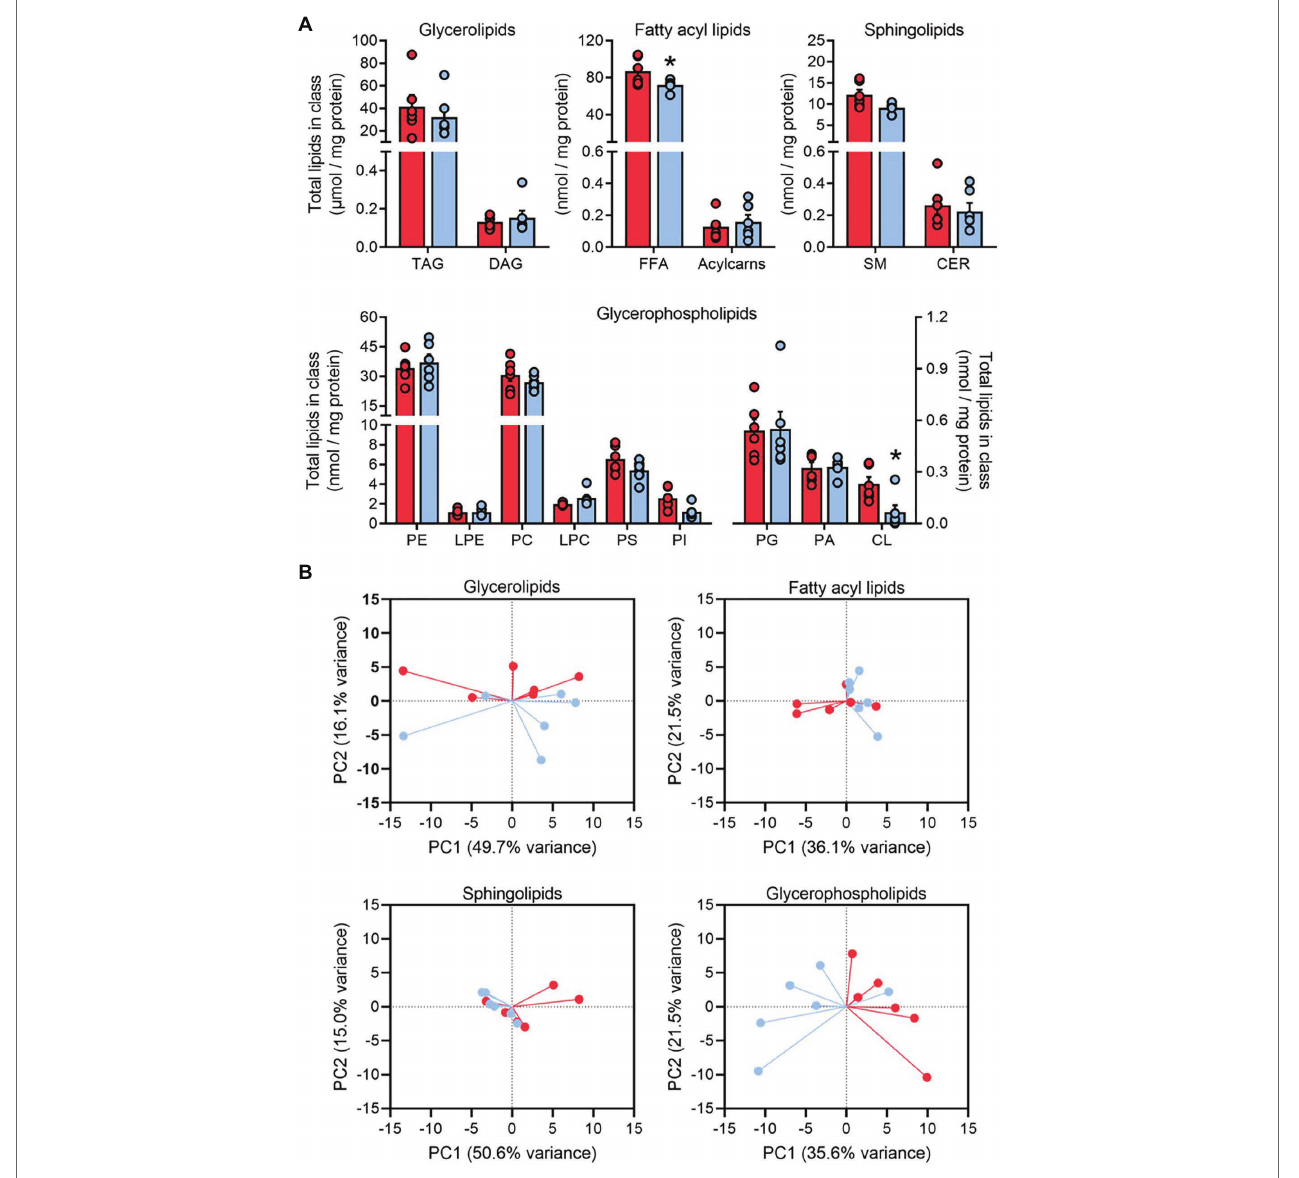
FIGURE 2 | The glycerophospholipid profile responds to pioglitazone treatment in adipose tissue. Lipid class totals in adipose tissue (A) for triglyceride, diacylglyceride, free fatty acids, acylcarnitine (acylcarns), sphingomyelin (SM), ceramide, phosphatidylethanolamine (PE), lyso-phosphatidylethanolamine, phosphatidylcholine (PC), lyso-phosphatidylcholine, phosphatidylserine (PS), phosphatidylinositol (PI), phosphatidylglycerol (PG), phosphatidic acid (PA), and cardiolipin (CL) normalized to adipose protein content. * p < 0.05 vs. Baseline. Data are mean ± standard error (filled bars) and individual values (filled circles) for n = 6 subjects. Principal component analysis score plots of the first two principal components (B) summarizing the overall pattern of variance in glycerolipid, fatty acyl, sphingolipid, and glycerophospholipid pools from human adipose tissue at Baseline (red) and following 6 months of 45 mg/day pioglitazone treatment (blue). Note that pioglitazone-treated samples cluster separately along the x-axis (PC1) for glycerophospholipid